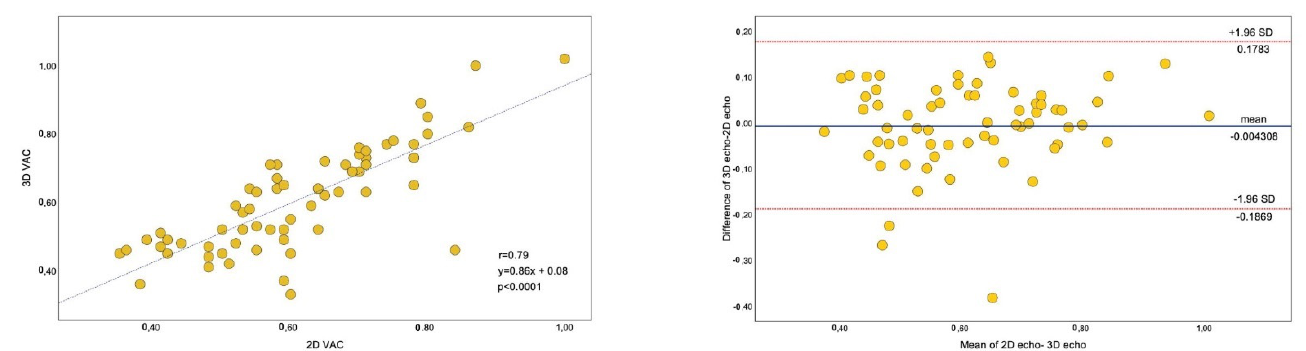
Figure 5. Linear regression ( left ) and Bland-Altman analysis ( right ) for VAC between 2D and 3D-echocardiography. Scattergram ( left panel) showing the correrelation plot between VAC obtained by 2D- and 3D echocardiography. Plot of the difference ( right panel) between the VAC measurements against their mean is shown. Medial line represents bias while the upper and lower red dotted lines the levels of agreement Dotted lines represent boundaries of means ± 2 SD, from − 1.96 to +1.96. Relative mean error was calculated by the ratio of absolute difference of two values over their average.